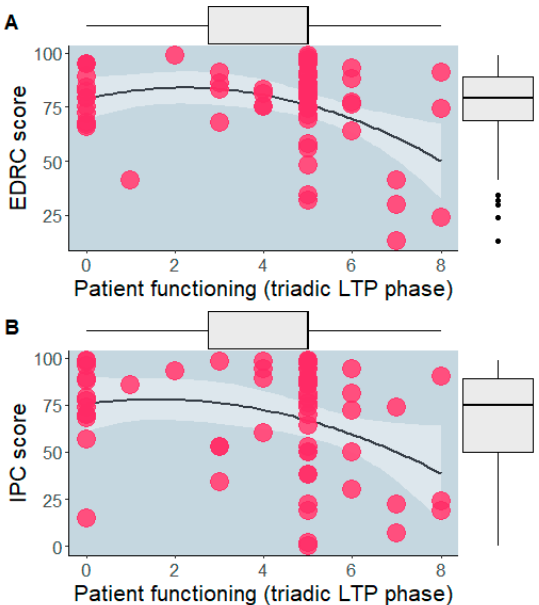
Figure 2. Associations between triadic phase score and EDRC ( A ) and IPC ( B ) ones. Significant differences emerged for the patient’s OR during the triadic phase in EDRC score ( F (2.57) = 5.51, p = 0.007, η 2 p = 0.16) and IPC score ( F (2.57) = 5.19, p = 0.009, η 2 p = 0.15). Post hoc analyses revealed that patients with high OR score had lower EDRC and IPC score compared to counterparts with low and moderate OR score. Additionally, sig- nificant differences emerged for the patient’s AC during phase 3 (triadic phase) in EDRC score ( F (2.57) = 3.82, p = 0.028, η 2 p = 0.12) and IPC score ( F (2.57) = 3.04, p = 0.055, η 2 p = 0.10). Post hoc analyses revealed that patients with high AC score had lower EDRC and IPC score compared to counterparts with low and moderate AC score (Figure 3). Figure 3. Significances between OR ( A ) and AC ( B ) and both EDRC and IPC.